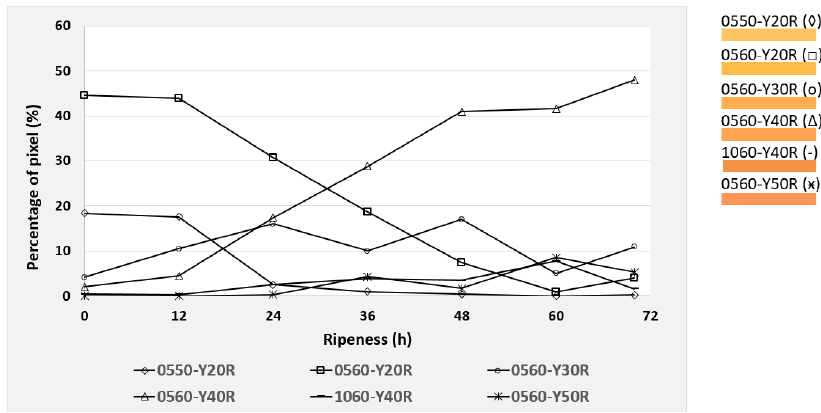
Figure 12. Development of the six most dominating pulp colors of cv. “Mahachanok” mangos during the 70 h post-ripening process, depicted as NCS color codes.